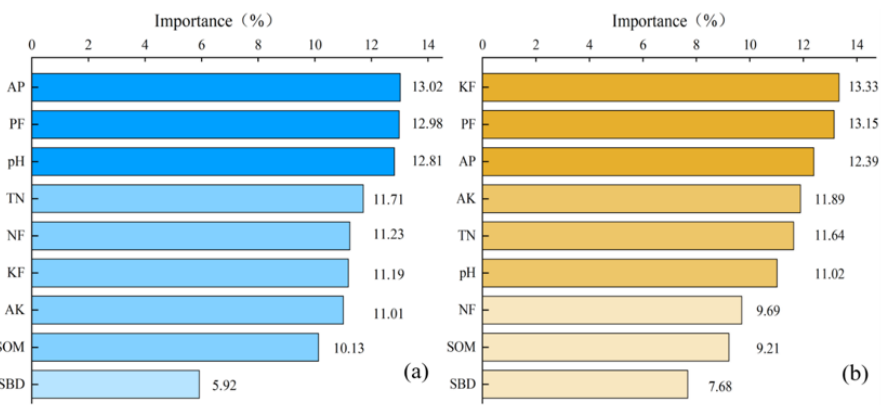
Figure 5. Influencing factors analysis under NPI ( a ) and CI ( b ). AP represents available soil phosphorus, PF represents application amount of phosphorus fertilizer, TN represents total soil nitrogen, NF represents application amount of nitrogen fertilizer, KF represents application amount of potassium fertilizer, AK represents available soil potassium, SOM represents soil organic matter, and SBD represents soil bulk density.